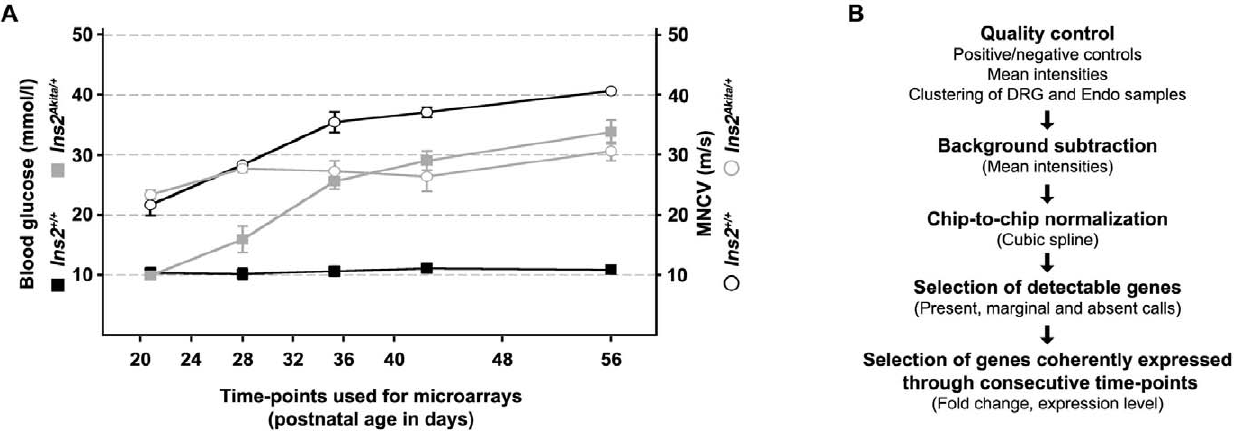
Figure 4. Design of the microarray experiment. A ) Eight time-points were selected between 20 and 56 days of age. This time window covers the pre-symptomatic situation (P20, 20 days old), the onset of hyperglycemia (P24–P28), the onset of DPN (P32–P36) and later time-points with a clear symptomatic situation (P36–P56) in Ins2 Akita/ + mice. Squares: blood glucose; circles: MNCV. B ) Schematic view of the microarray data analysis. doi:10.1371/journal.pone.0010832.g004 ( Fig. S3 ). This strategy aimed at selecting the most robust gene expression changes present through multiple time-points and helped us to efficiently eliminate the ‘‘zigzagging’’ expression